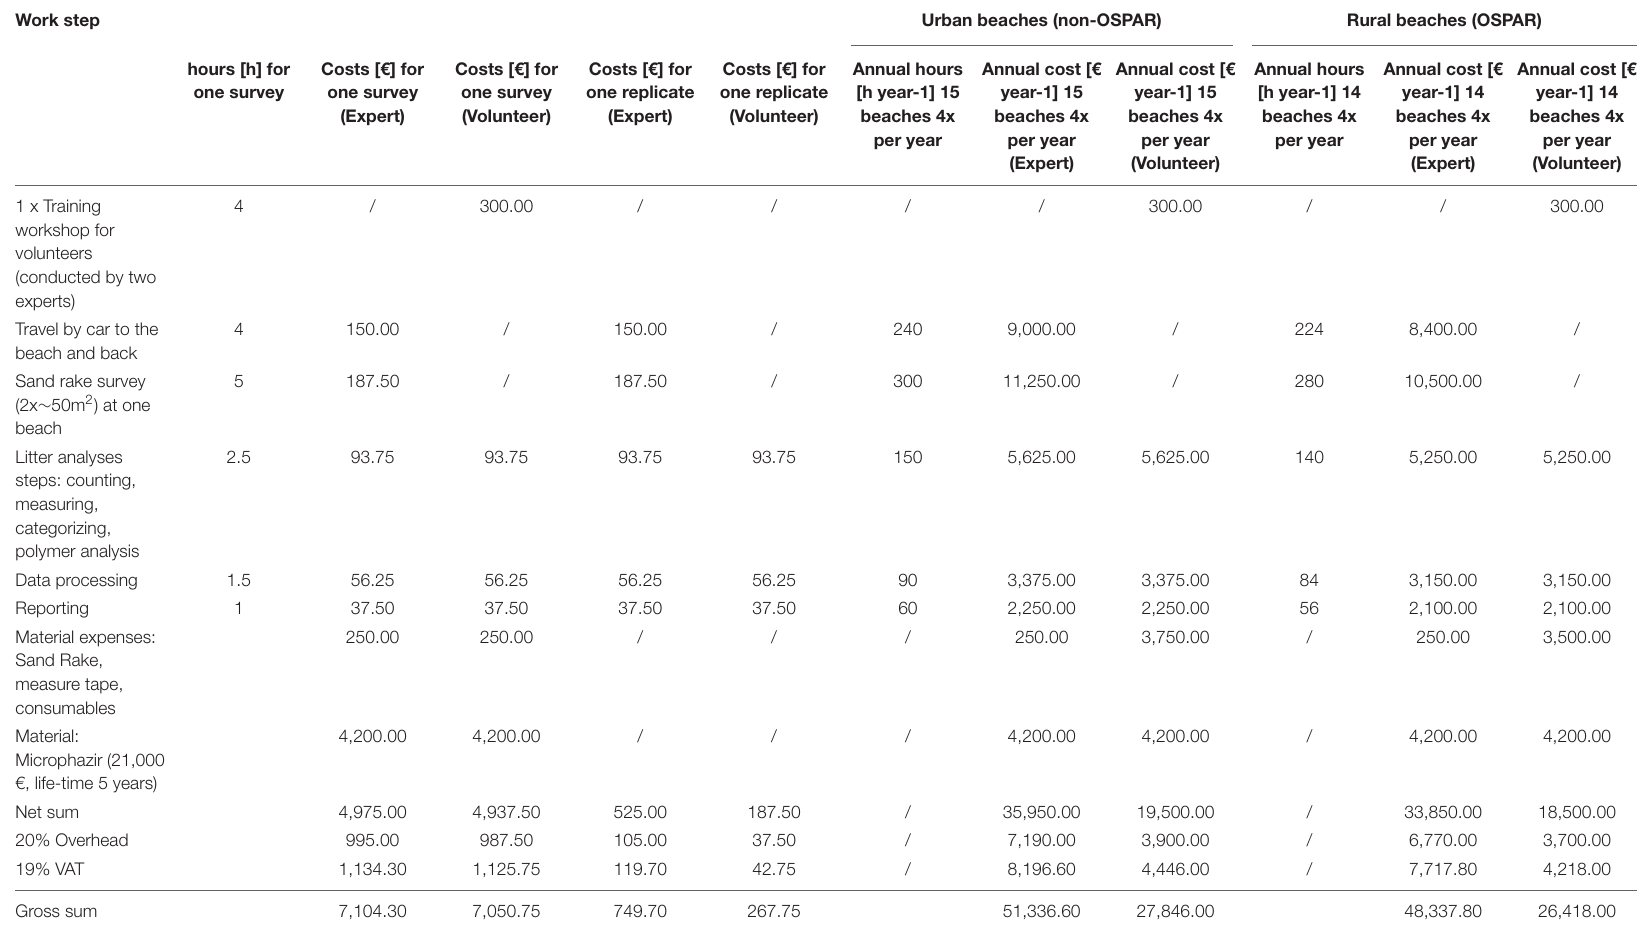
TABLE 4 | Hours (h) and costs (€) for a single sand rake method survey for an expert- and a volunteer-based approach (left) and the costs of further replicates at the same